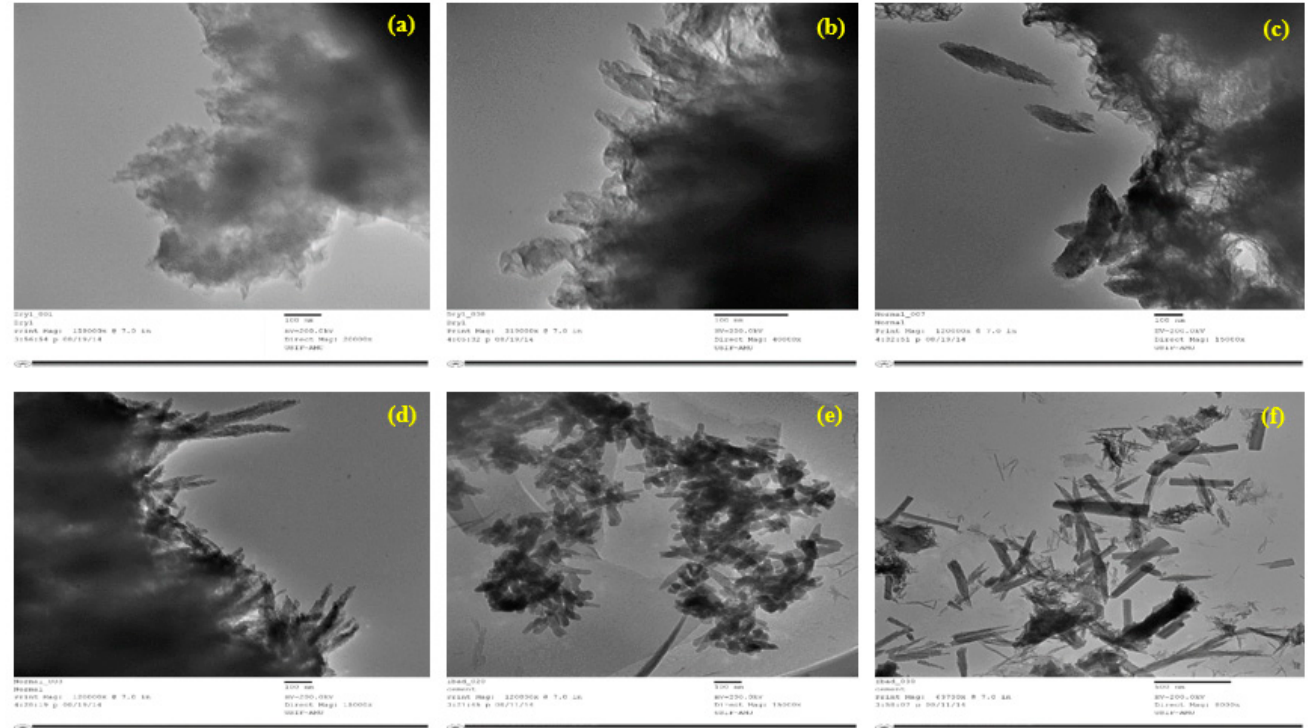
Figure 5. TEM images of ( a ) normal cement, ( b ) normal cement (another view), ( c ) dry-ground nano-cement, ( d ) dry-ground nano-cement (another view), ( e ) wet-ground nano-cement, and ( f ) wet- ground nano-cement (another view).